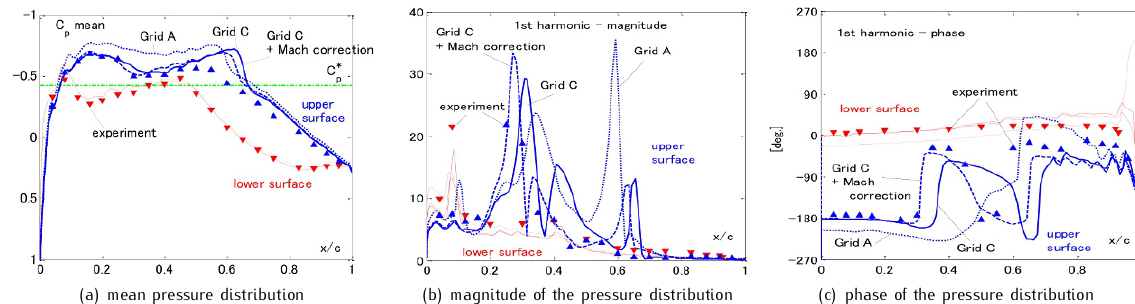
Figure 12. Unsteady pressure distribution (#09237).